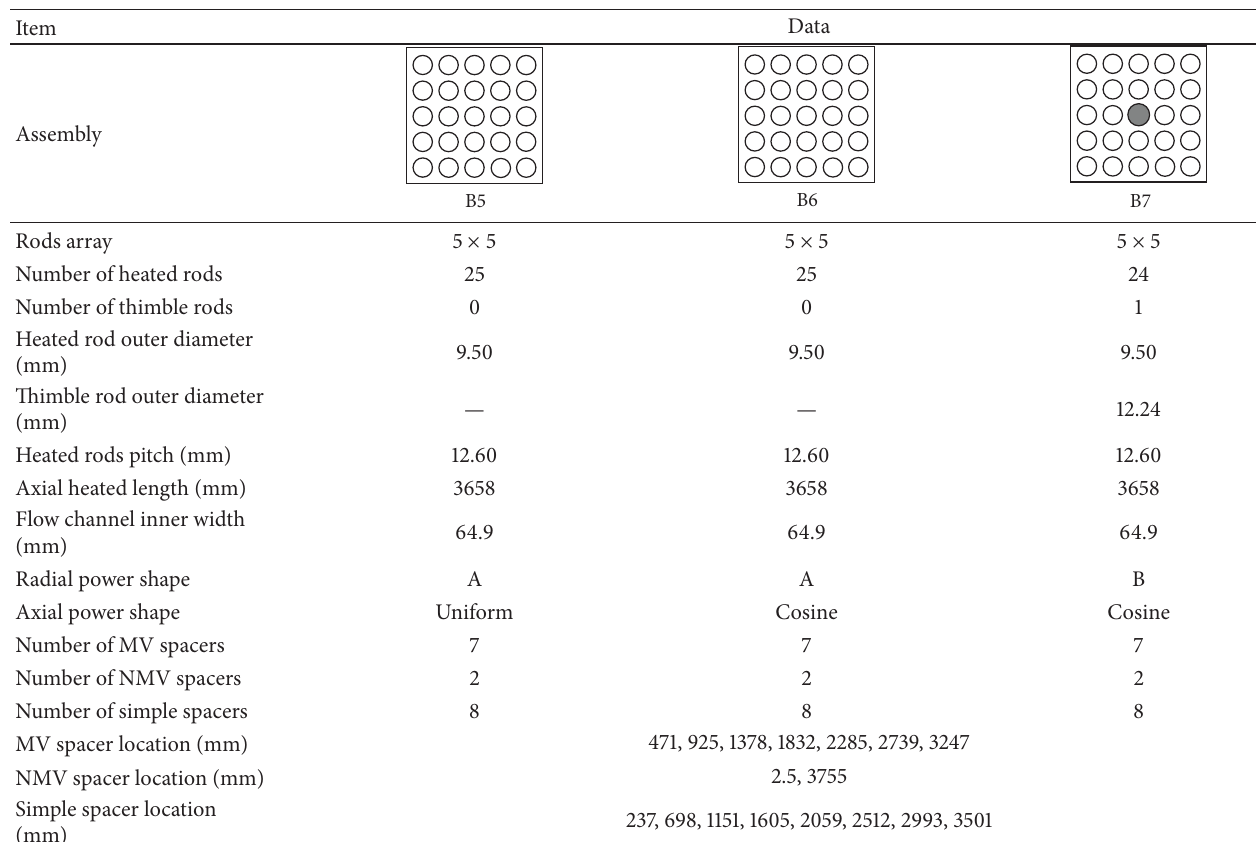
Table 7: Assembly data for assemblies B5, B6, and